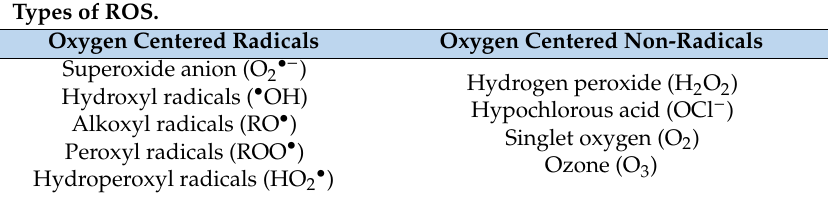
Table 1. Examples of reactive oxygen